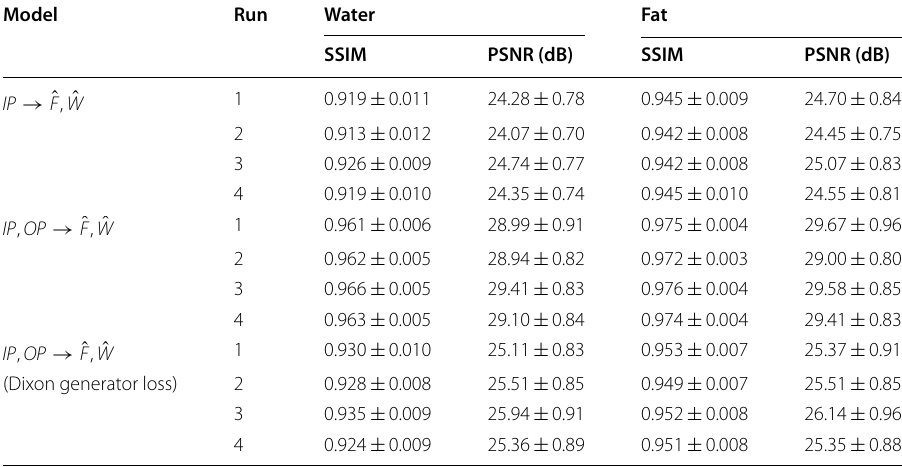
Values reported are the average and standard deviation. The three models are: single-input IP → ˆ F , ˆ W , dual-input IP , OP → ˆ F , ˆ W and dual-input (Dixon generator loss) IP , OP → ˆ F , ˆ W